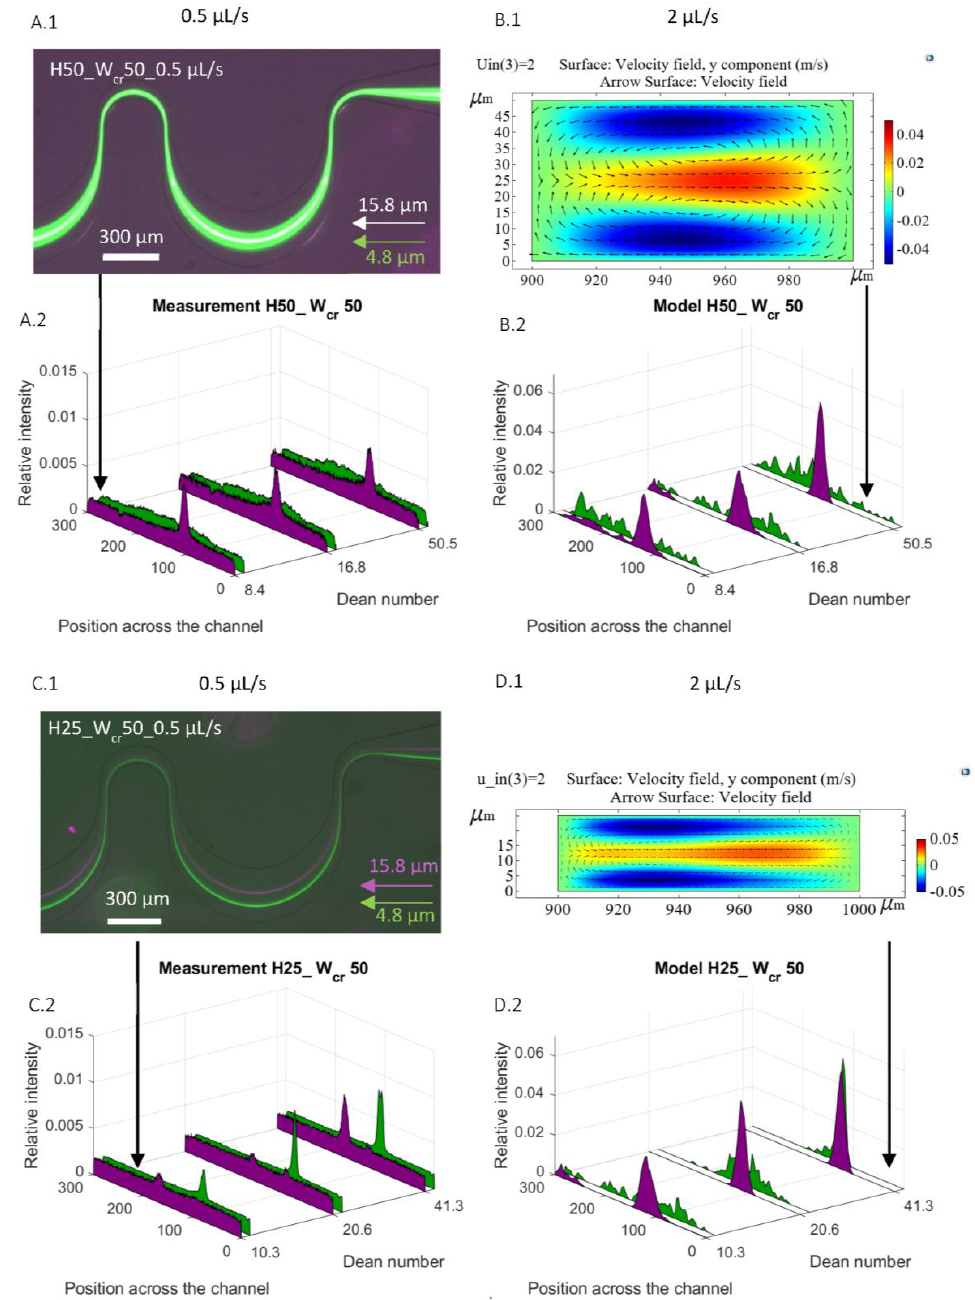
Figure 3. Comparison of the lateral focusing of rigid polystyrene beads (Ø 4.8 µ m and Ø 15.8 µ m) in periodic curved channels with the same critical width and different channel heights (W cr = 50 µ m; H = 50 and 25 µ m) at flow rates of 0.5, 1, 2 µ L/s. Experimental results ( A.1 , A.2 , C.1 , C.2 ) are visualized by the fluorescence-intensity-based lateral distribution of the beads detected in the bigger curve (in 300 µ m cross-sectional width). ( A.1 ) shows the lateral focusing position of the selected beads in channel H50_W cr 50; ( C.1 ) in channel H25_W cr 50, both at 0.5 µ L/s flow rate; and the experimental results are summarized respectively in the same channel represented on a graph at 0.5, 1, 2 µ L/s ( A.2 , C.2 ). Numerical results ( B.1 , B.2 , D.1 , D.2 ) are demonstrated by the velocity field distribution in the smaller curve (in W cr + 50 µ m cross-sectional width): ( B.1 ) in channel H50_W cr 50, ( D.1 ) in channel H25_W cr 50, both at 2 µ L/s flow rate; and respectively in the same channel the lateral distribution of the beads detected in the bigger curve (in 300 µ m cross-sectional width) at 0.5, 1, 2 µ L/s ( B.2 , D.2